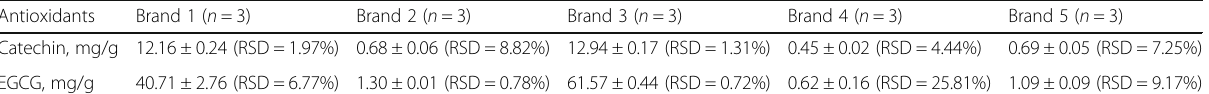
Table 3 Antioxidants present per gram of tea samples (extracted in hot water for 20 min) separated in an HPLC with CUPRAC post-column derivatization using phenyl-hexyl core-shell column